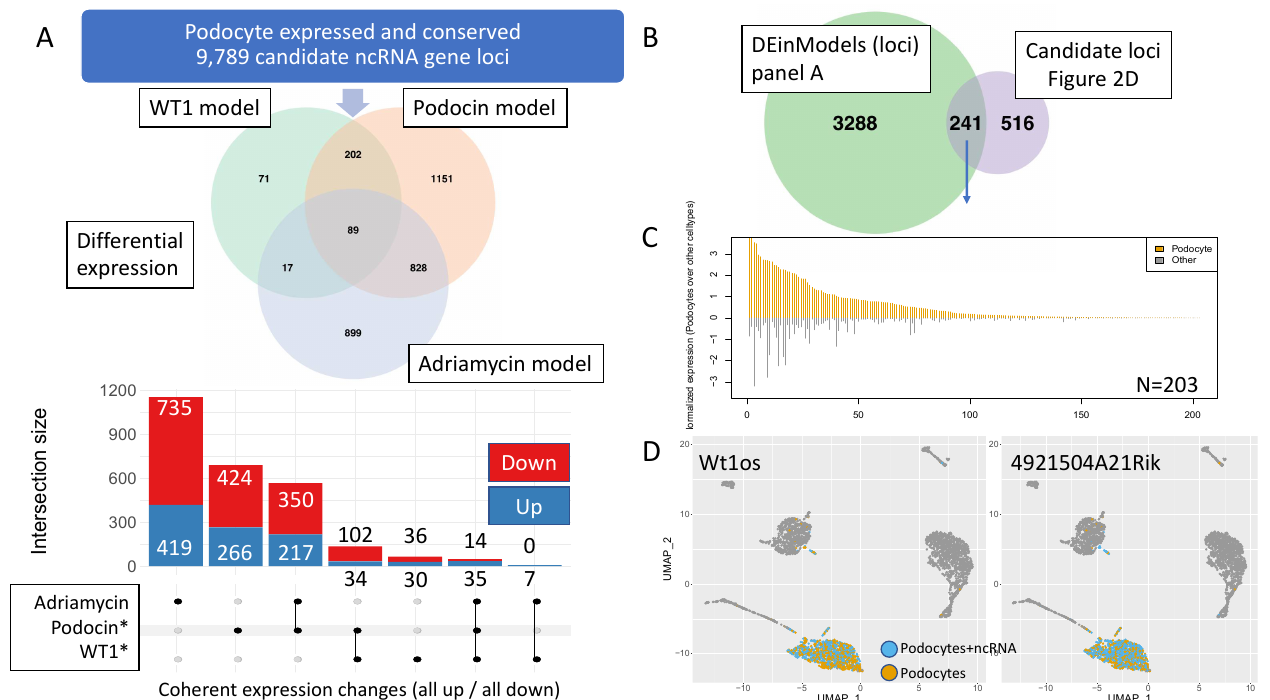
Figure 3. Dysregulation of lncRNAs in three mouse models of FSGS and validation of cell-type specificity using scRNA-seq data. ( A ) Venn diagram of differential lncRNA candidate gene loci expression across three disease models (top). Additional details on co-regulation across disease models is given at the bottom bar chart. *The two-factor model (age, condition) is used for Podocin and WT1. ( B ) Overlap of differential gene expression with the 757 conserved, podocyte-specific lncRNA candidate loci from Figure 2D. ( C ) Re-assessment of differentially regulated candidate loci from Figure 2D with regards to podocyte-specificity using single cell data from Chung et al. JASN 2020. We could identify 203 out of 241 lncRNA loci as expressed in 3′ scRNA data with the majority being podocyte-specific. ( D ) Uniform Manifold Approximation and Projection graphs (UMAPs) of two examples of highly podocyte-specific and conserved lincRNAs in scRNA-seq data (Chung et al. JASN 2020): Wt1os and 4921504A21Rik.